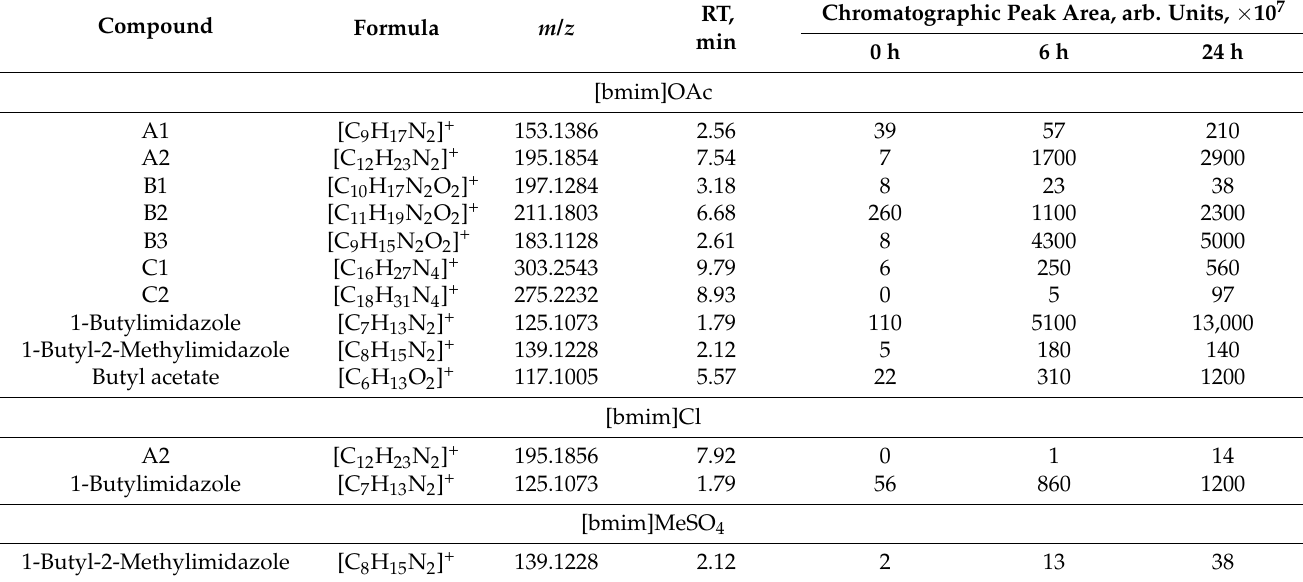
Table 3. The main low-volatile IL degradation products identified by HPLC-HRMS before (0-h) and after 6- and 24-h thermal treatment at 150 ◦